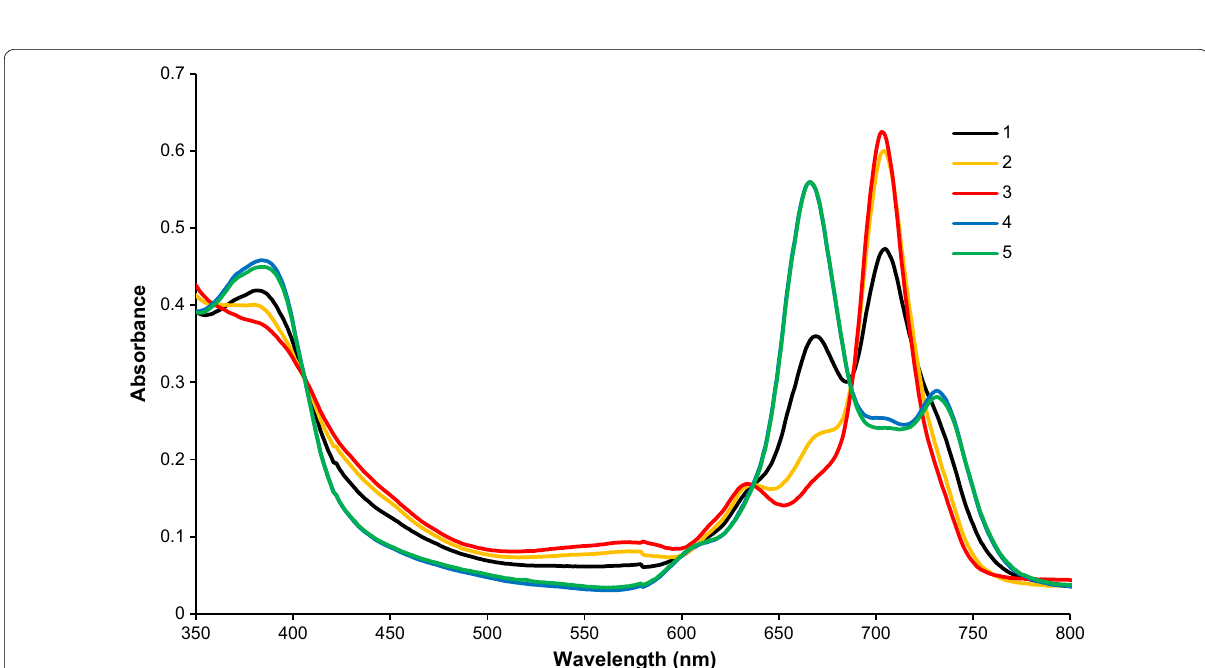
Fig. 5 UV–vis spectra of 4 in toluene at 20 mg l − 1 upon addition of acetic acid (AcOH). 1 : without AcOH; 2 : addition of 5 μl AcOH, reaction time 5 min; 3 : as 2 , but after 30 min; 4 : as 3 , but addition of 10 μl triethylamine (Et 3 N); 5 : control—addition of 10 μl Et 3 N to